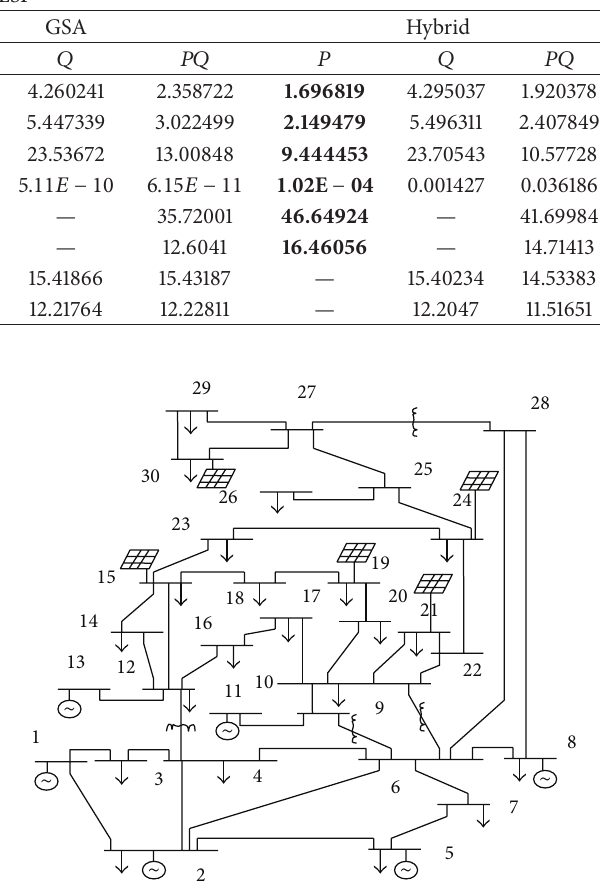
Figure 3: Test system after addition of DGs at 5